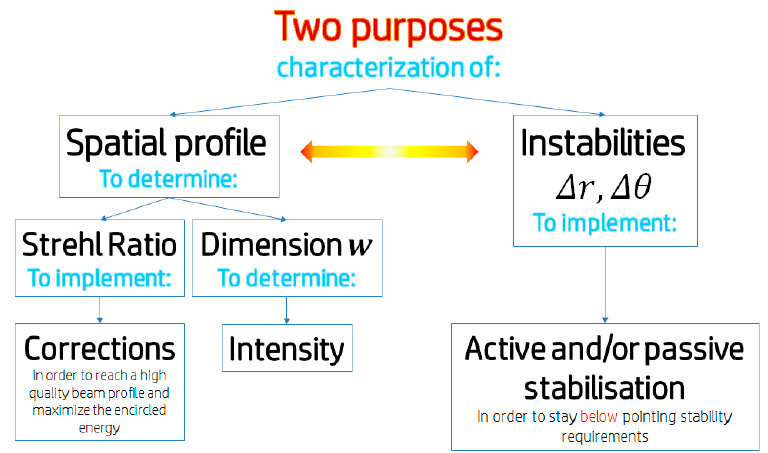
Figure 12. Preliminary flow chart of the laser stability diagnostics and control in the focal point.